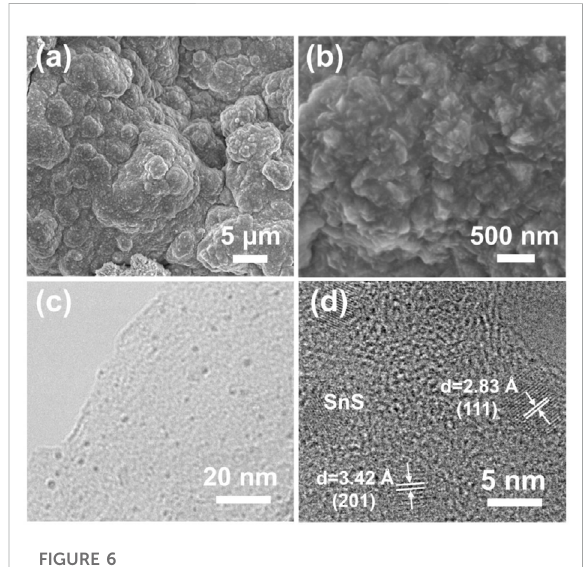
FIGURE 6 (A,B) SEMand (C,D) TEMimagesofSnS@C/Gcompositeafter 100